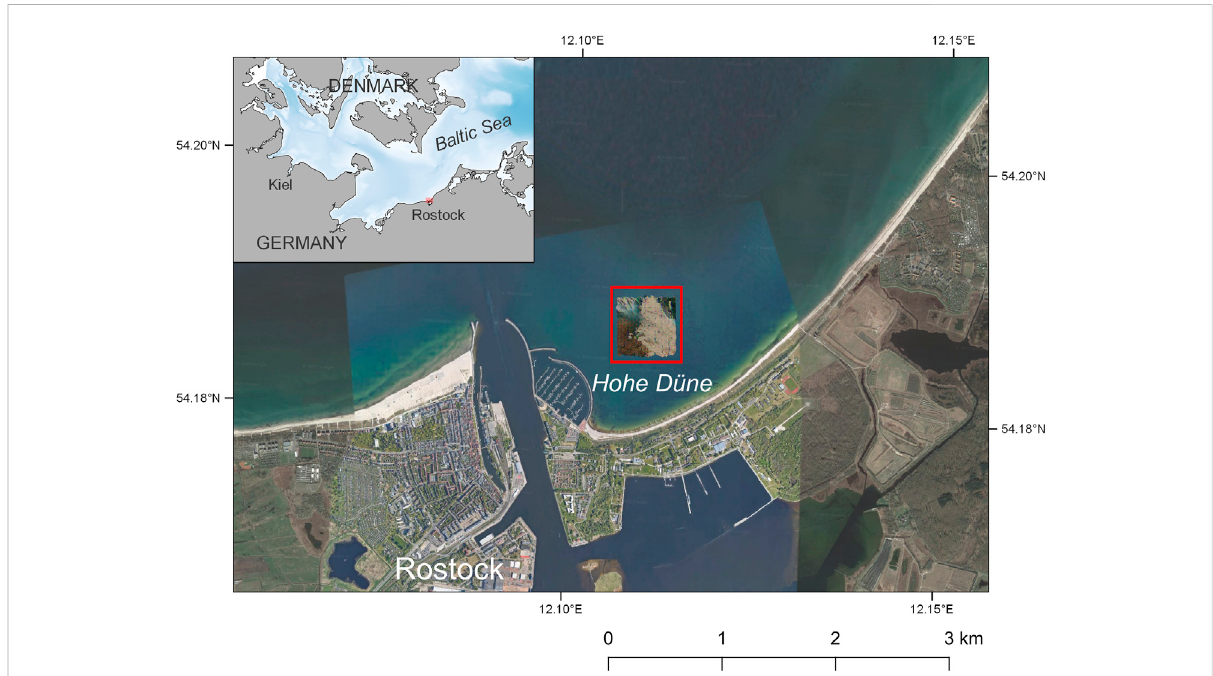
FIGURE 1 Location of the Hohe Düne research area close to the coast of Rostock in the southwestern Baltic Sea. Map projection is UTM33N WGS84. Background image: Google Maps